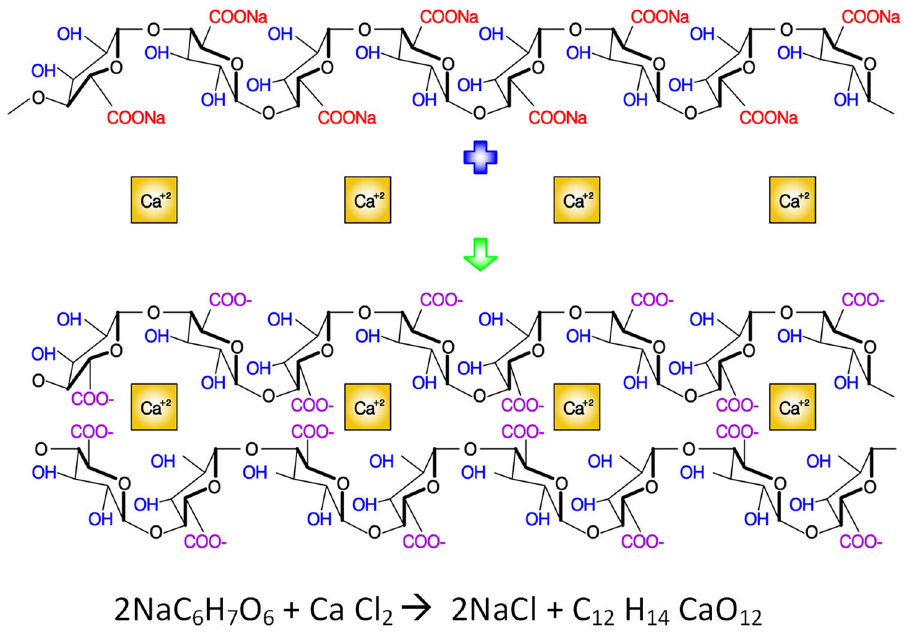
Figure 3. Crosslinking of sodium alginate with calcium chloride.